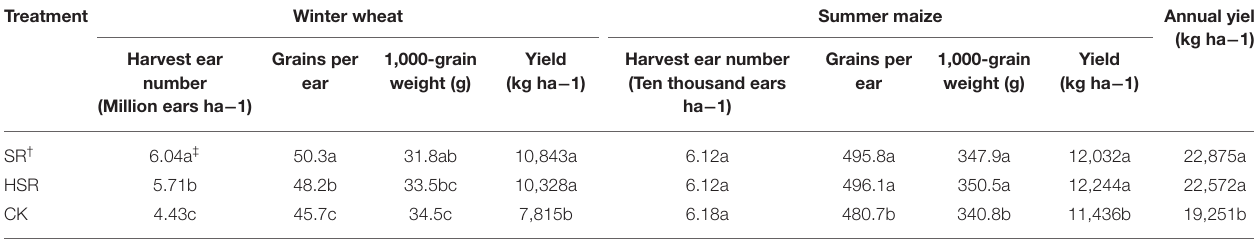
TABLE 1 | Effect of different amount of corn stover returned to the field on yield and its components of summer maize and Winter wheat in 2017.